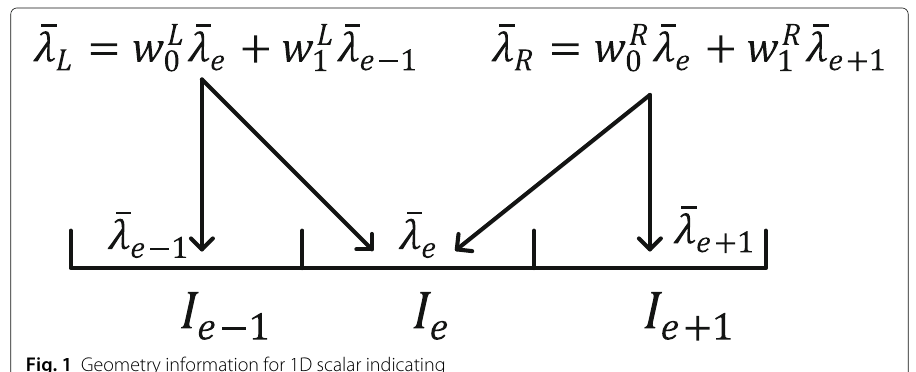
Fig. 1 Geometry information for 1D scalar